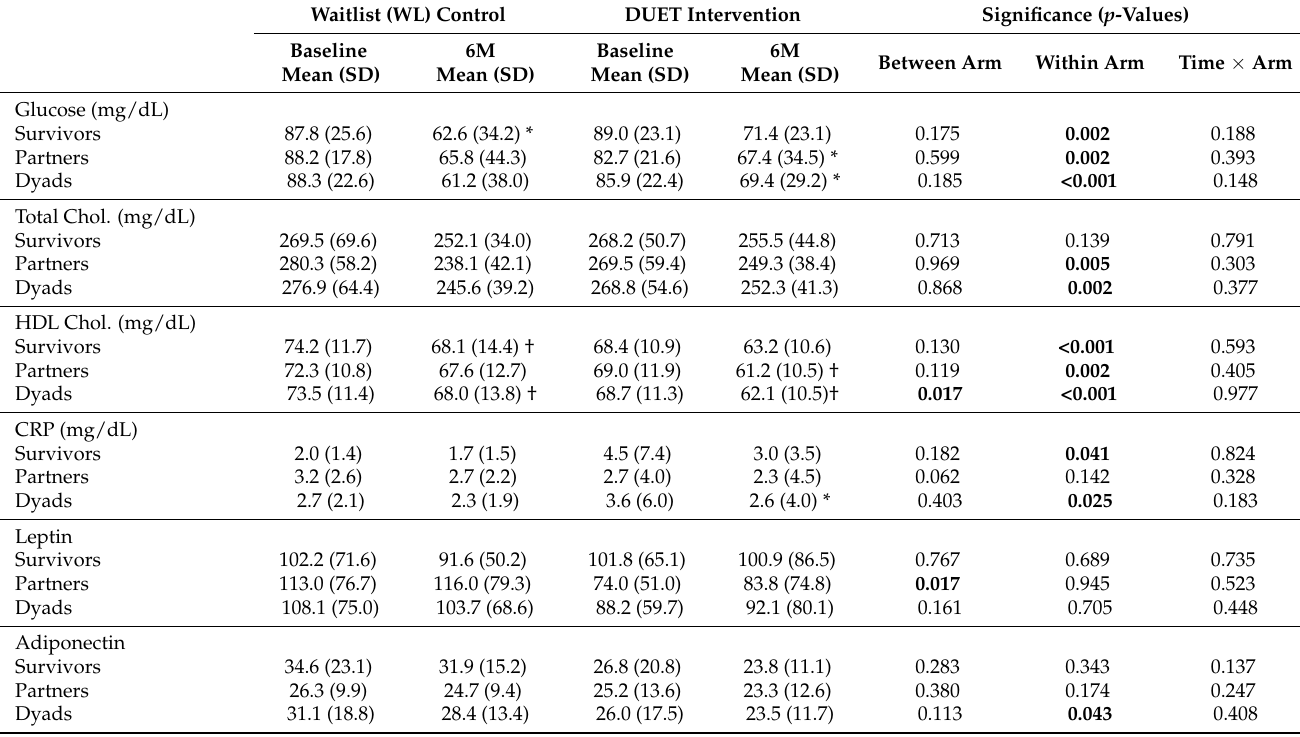
Table 4. Baseline to 6-month differences in circulating biomarkers in waitlisted vs. DUET intervention study